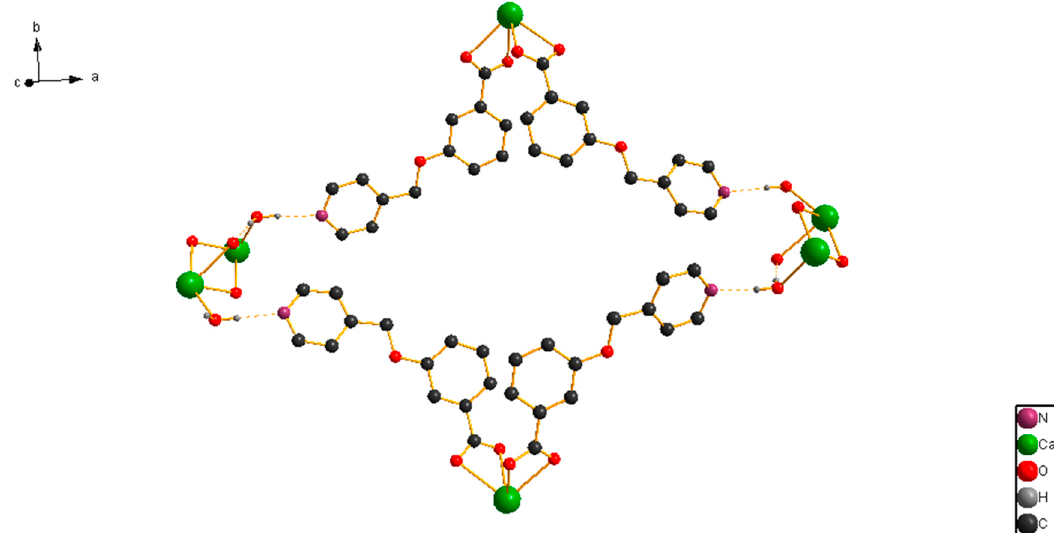
Figure 3. The looped structure by hydrogen bonds in [CaL 2 (H 2 O) 2 ] n .